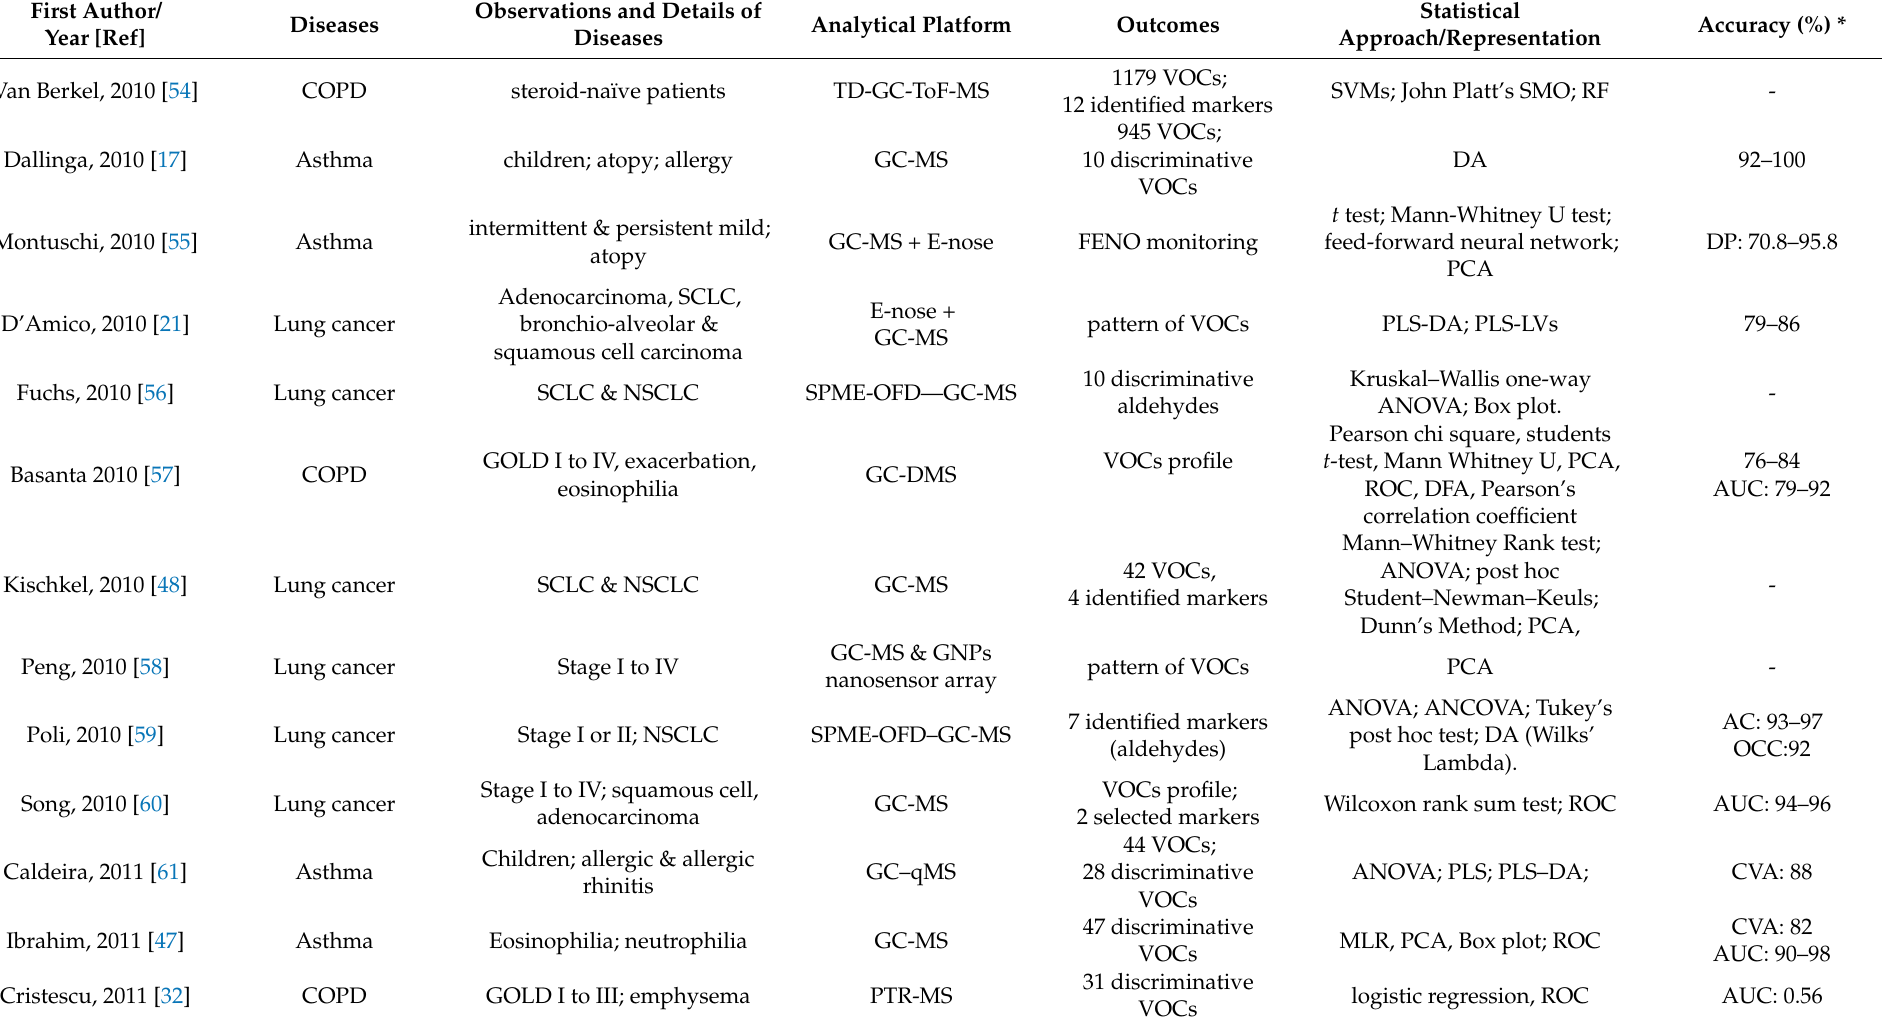
Table 2. Details of clinical studies